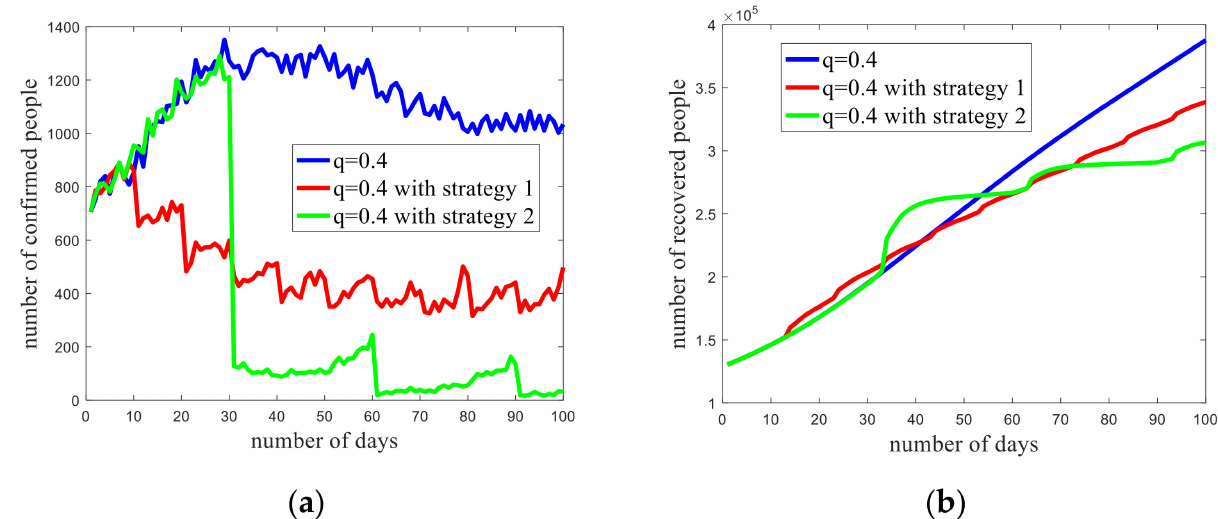
Figure 7. ( a ) Simulation results of Iowa under different diagnostic test strategies (different test strategies have different intervals and scales). ( b ) The trend of the number of recovered corresponding to different